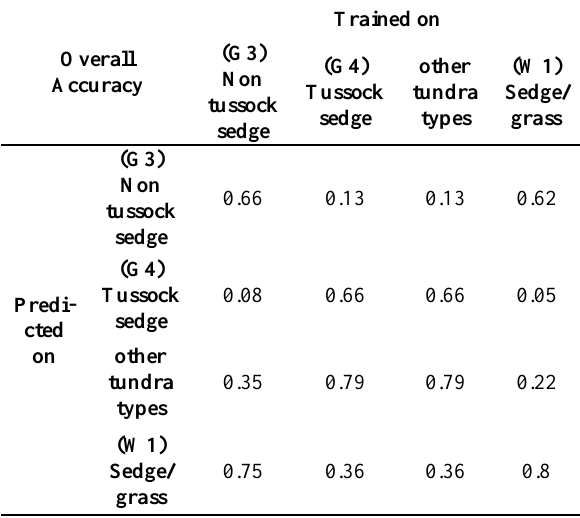
Table 3. Overall accuracy values for models trained on different tundra